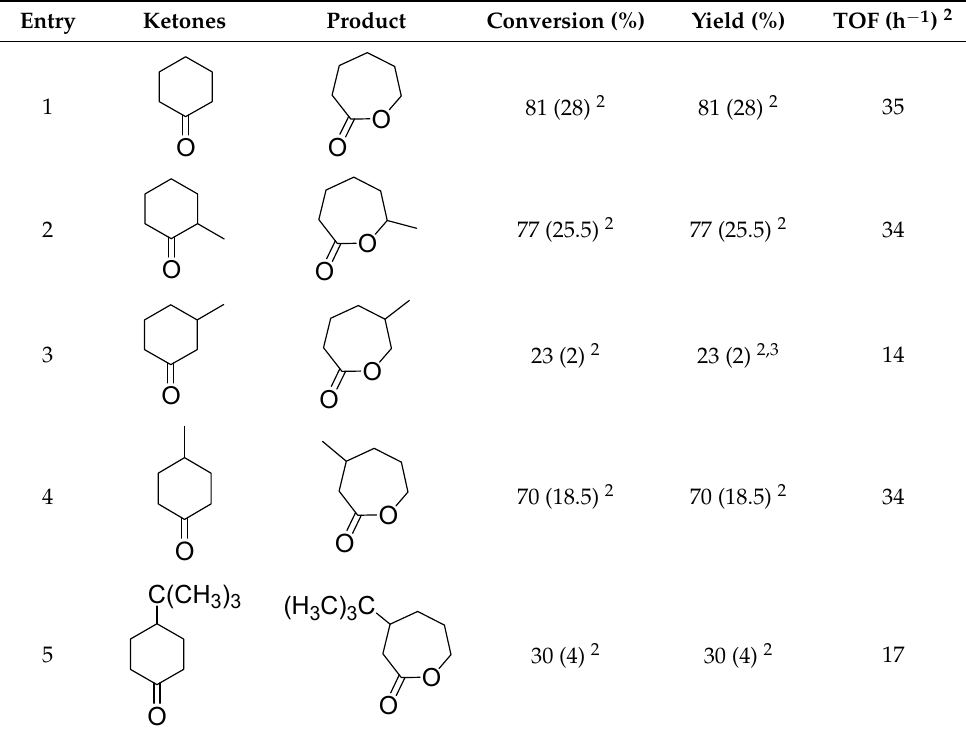
Figure 2. Preliminary kinetic study on the iron(II)-catalyzed Baeyer–Villiger oxidation of cyclohex- anone by molecular oxygen in the presence of benzaldehyde. ( a ) Plot of conversion versus catalyst ( 2 ) concentration; ( b ) Plot of conversion versus benzaldehyde concentration reaction conditions: [ 2 ] (0.01–1.0 × 10 − 2 mM), cyclohexanone (10 mM), benzaldehyde (25–175 mM), CH 3 CN (5 mL), O 2 bubbling, 60 °C, 15 h. Table 3. Oxidation of various ketones by dioxygen in the presence and absence of [Fe(PBT)(OTf) 2 ] ( 2 ) 1 .